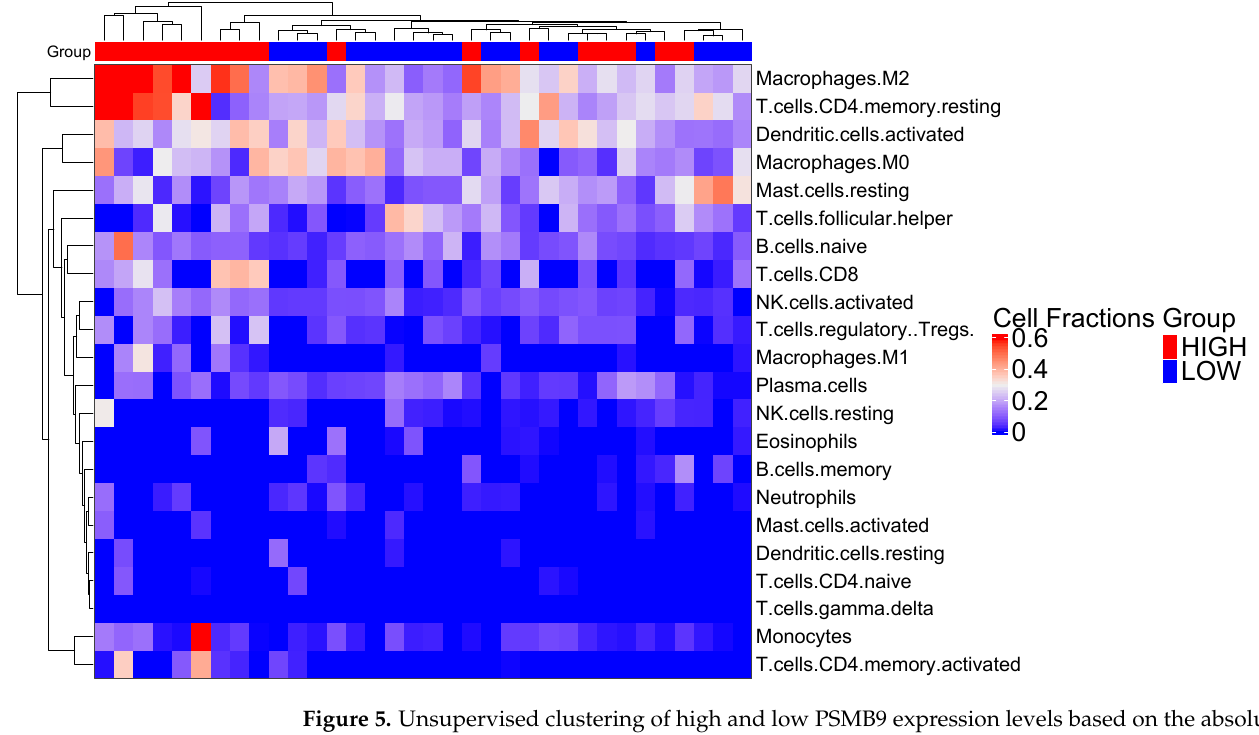
Figure 5. Unsupervised clustering of high and low PSMB9 expression levels based on the absolute cell fractions estimated by CIBERSORTx.